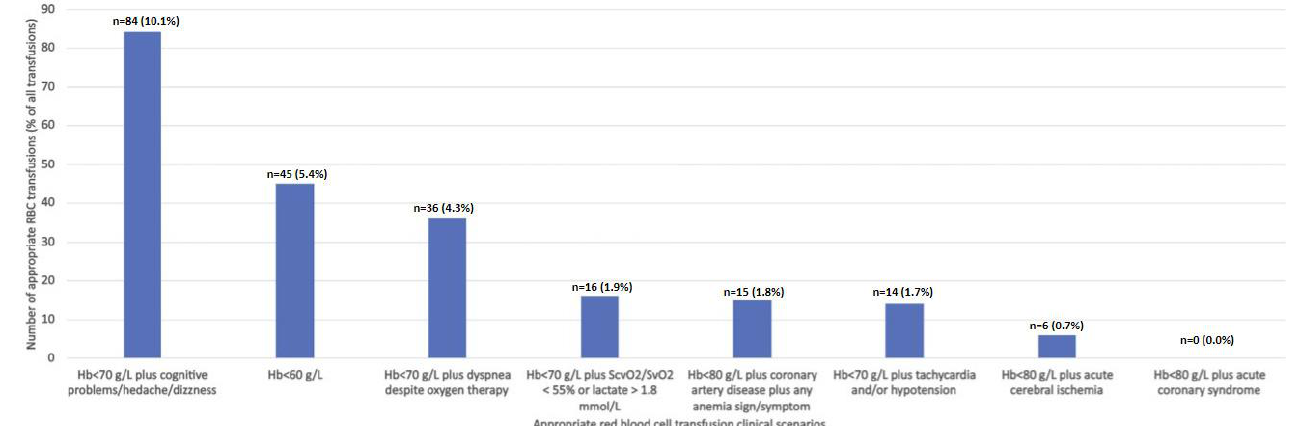
Figure 1. Number of appropriate RBC transfusions (percentage of all RBC transfusions) in various clinical scenarios classified as appropriate indications for RBC transfusion (Table 1). RBC, red blood cell.